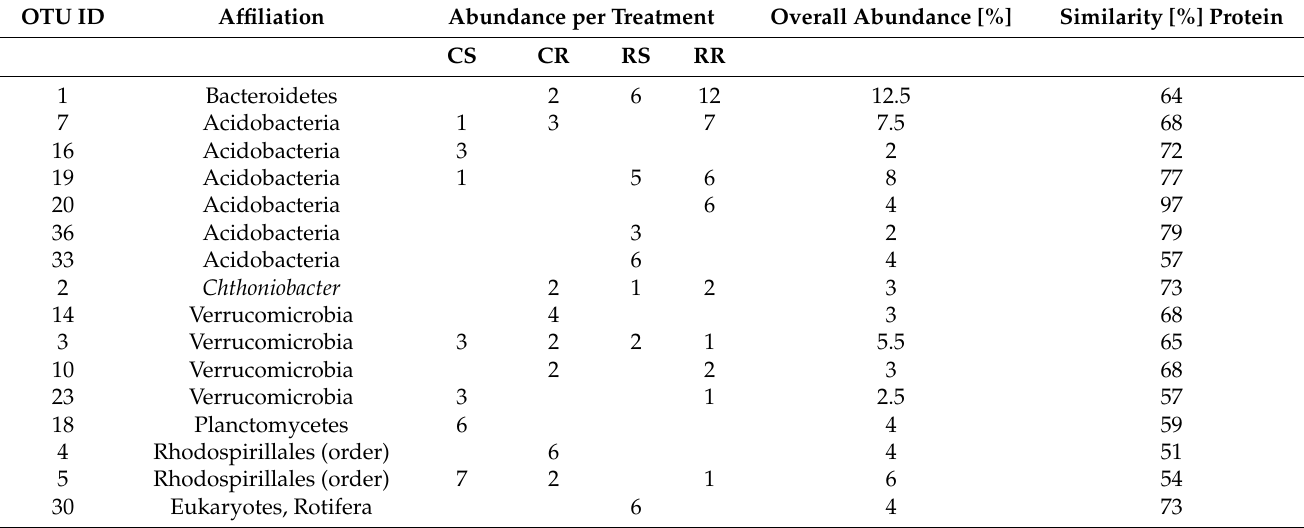
Table 3. Taxonomic assignment of representative desulfonating Operational Taxonomic Units (OTUs) derived from clonal atsA nucleic acid sequence analysis from static hyphosphere cores (CS), rotating hyphosphere cores (CR), rhizosphere roots from microcosms with static cores (RS) and rhizosphere roots from microcosms with rotating cores